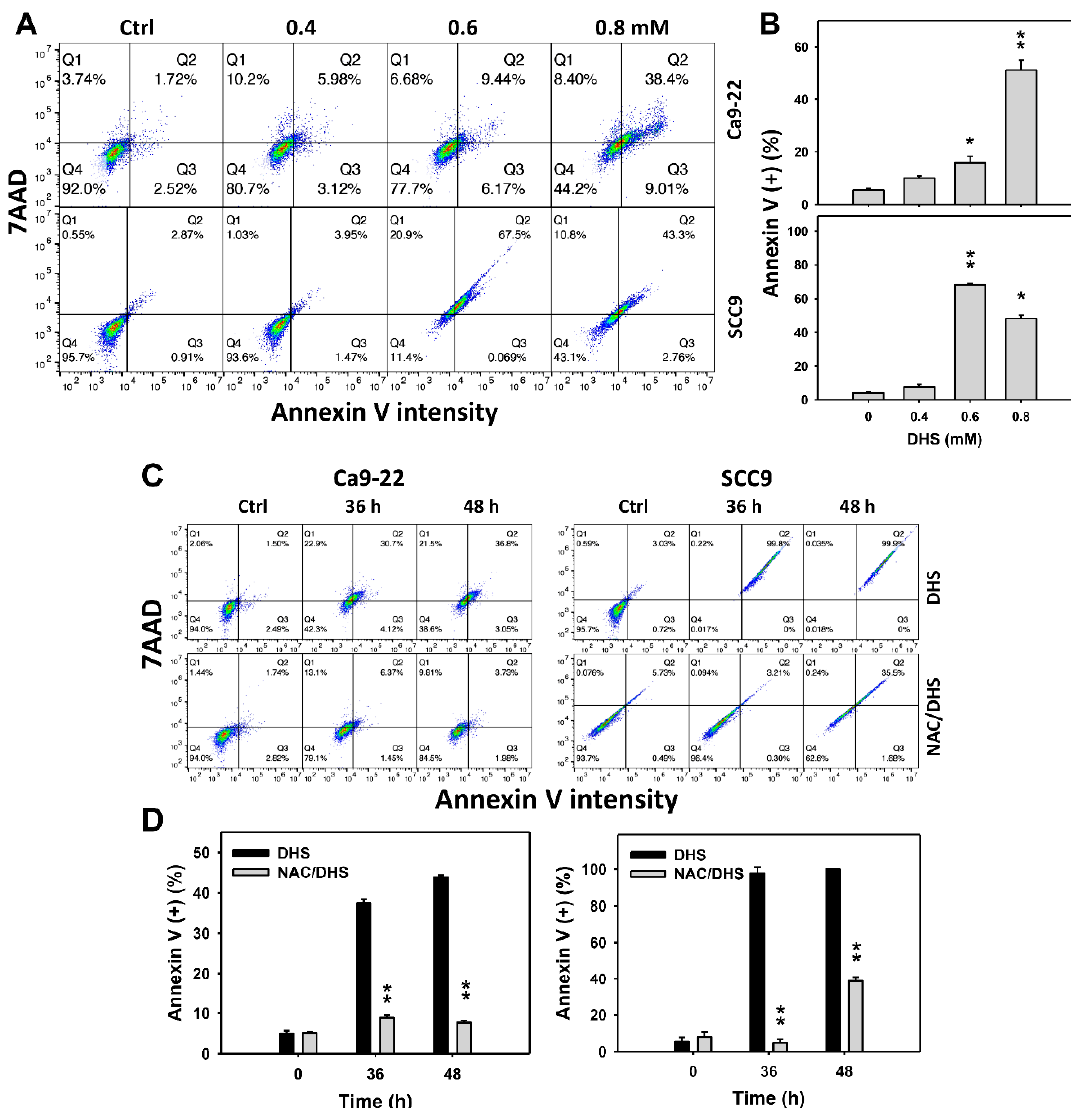
Figure 3. DHS effects on annexin V/7AAD-detected apoptosis of oral cancer cells. ( A , B ) Representative annexin V/7AAD patterns of DHS-treated oral cancer cells. Cells (Ca9-22 and SCC-9) were treated with 0.4, 0.6 and 0.8 mM DHS or vehicle (containing 0.08% DMSO) for 48 h. ( C , D ) Alleviation of the annexin V/7AAD changes of DHS-treated oral cancer cells by NAC. Cells were pretreated with NAC (4 mM, 1 h) or not, and then they were treated with 0.6 mM DHS or vehicle for 0, 36 and 48 h. Data = means ± SDs ( n = 3 independent experiments). * and ** indicate significant differences between ( A , B ) DHS and control and ( C , D ) DHS and NAC/DHS ( p < 0.05 and 0.01, respectively). A positive control for annexin V/7AAD-detected apoptosis of oral cancer cells is provided in Supplementary Figure S1.